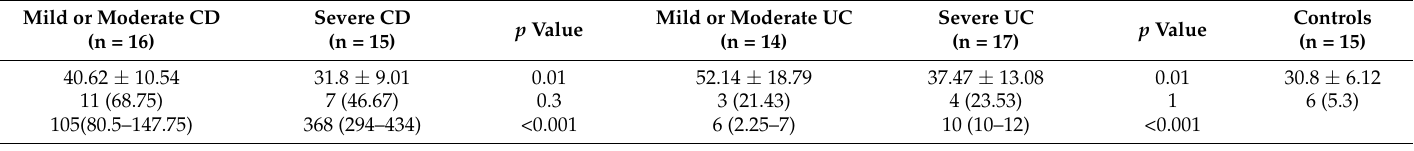
Table 1. Baseline characteristics of the study